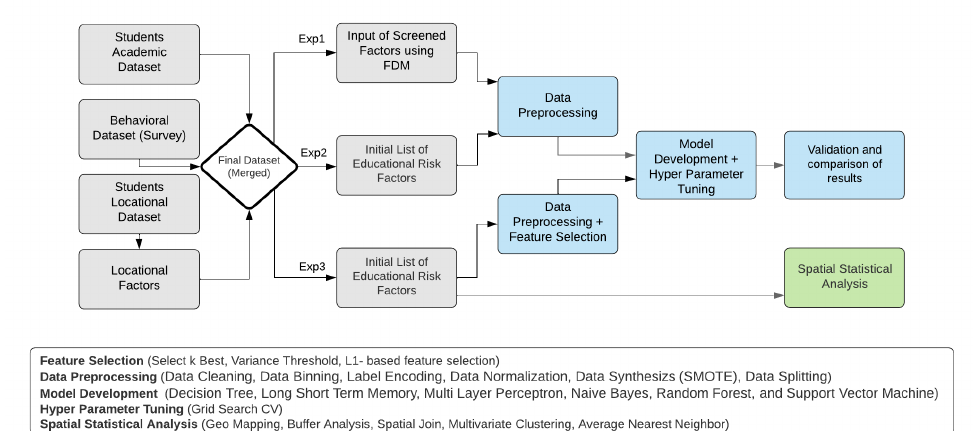
Figure 7. Dataset